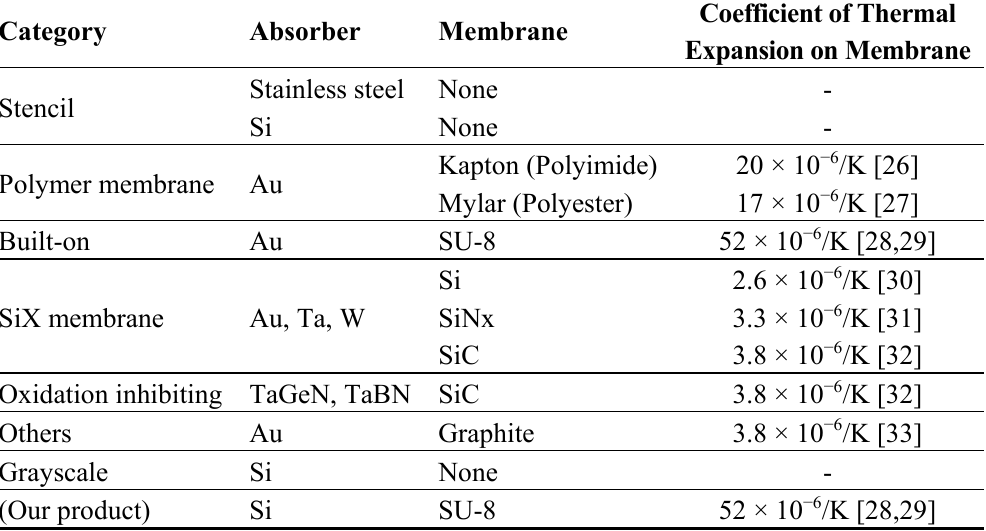
Table 1. Materials of X-ray